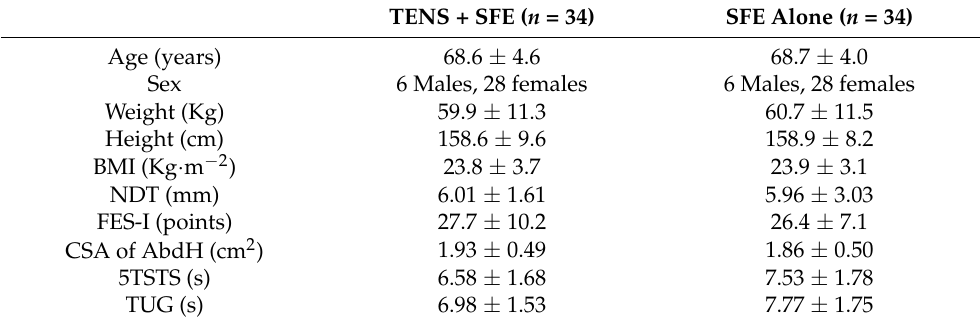
Table 1. Physical characteristics and pre-measurements of participants of the study ( n =